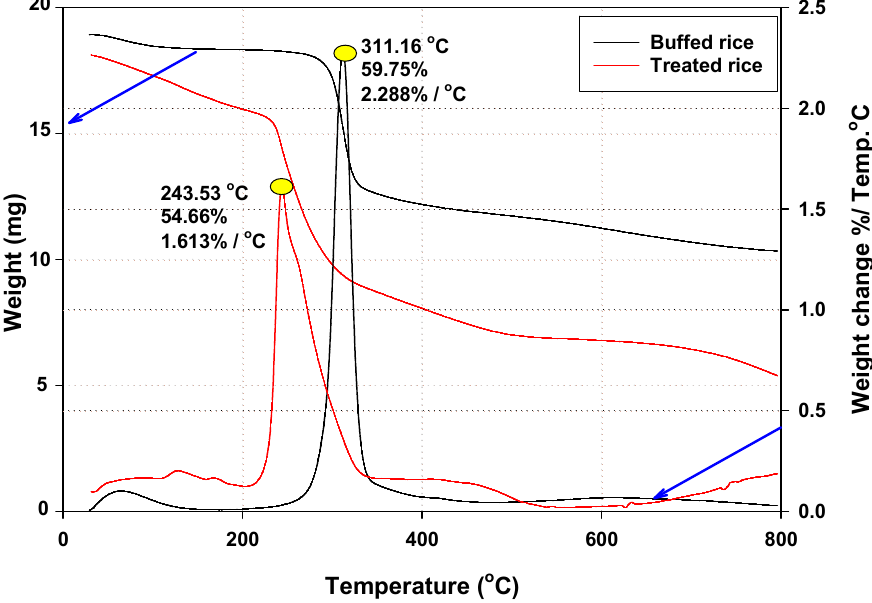
Figure 11. TGA and DTG curves of fresh puffed and treated rice cakes.